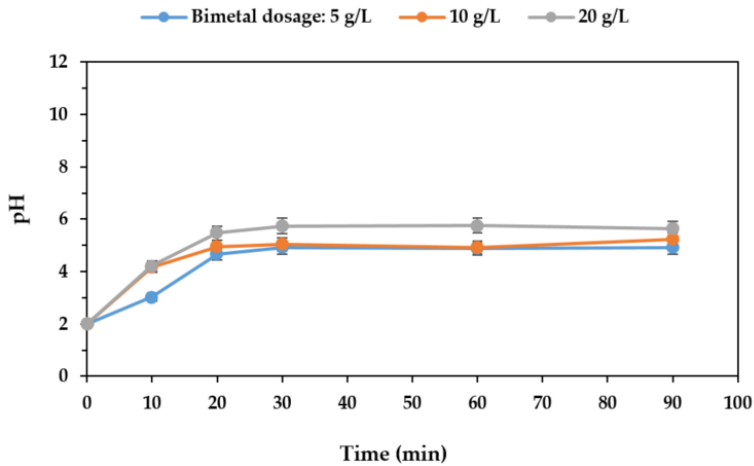
Figure 4. Variation in the pH of the combined AMD solution treated by the Fe-Al bimetal at a different time and bimetal dosage.